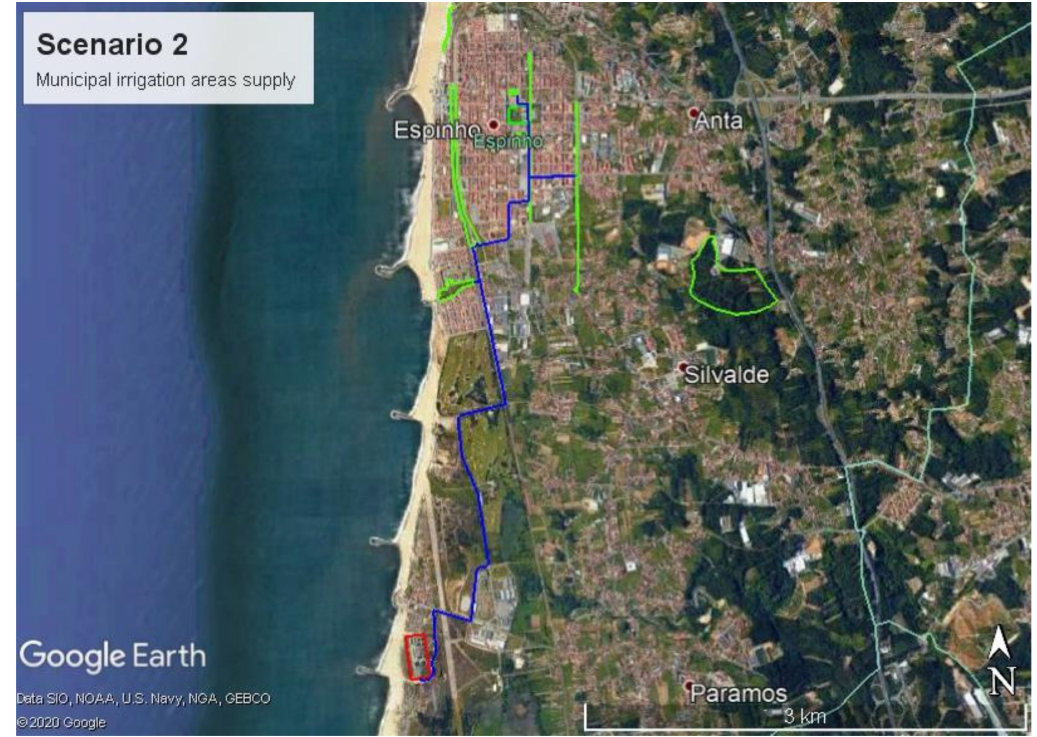
Figure 6. Scenario 2: WtR supply, provided by Espinho WWTP (in red), by pressurized network (pipe in blue) to the municipal irrigation areas marked in